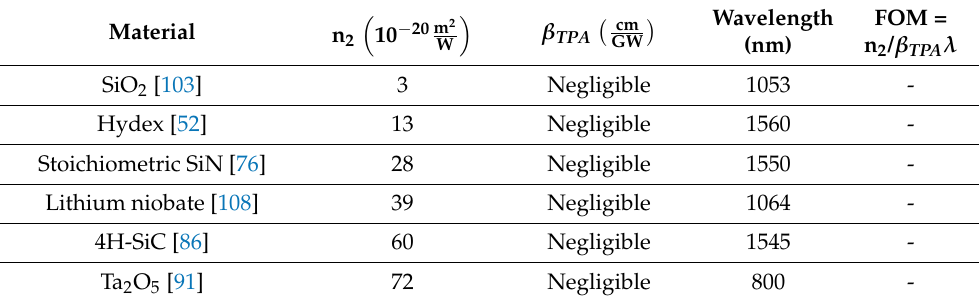
Table 1. Nonlinear refractive indices n 2 , two-photon absorption coefficients β TPA , and figures of merit (FOMs) of various